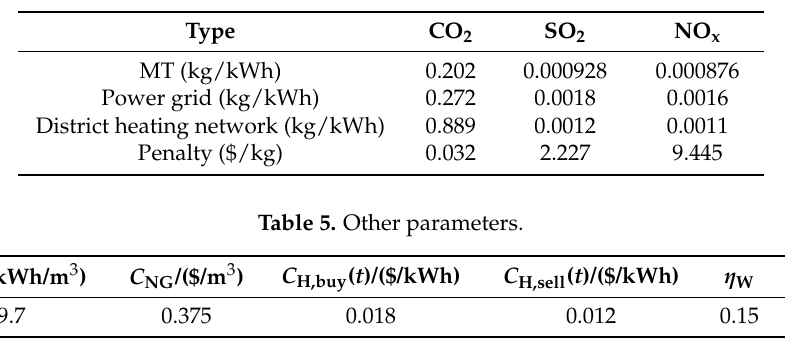
Table 4. Pollutant emission coefficients and penalty prices.